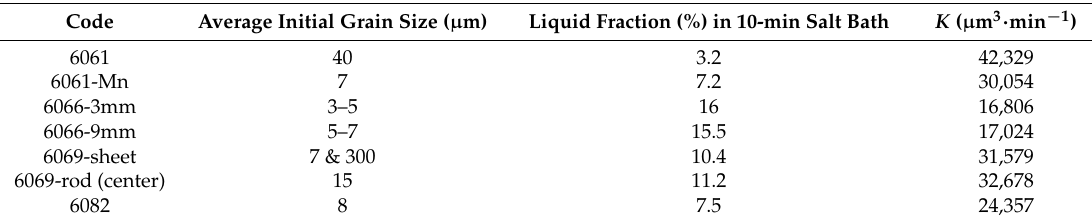
Table 2. The average initial grain size, liquid fraction, and growth rate of Al–Si–Mg